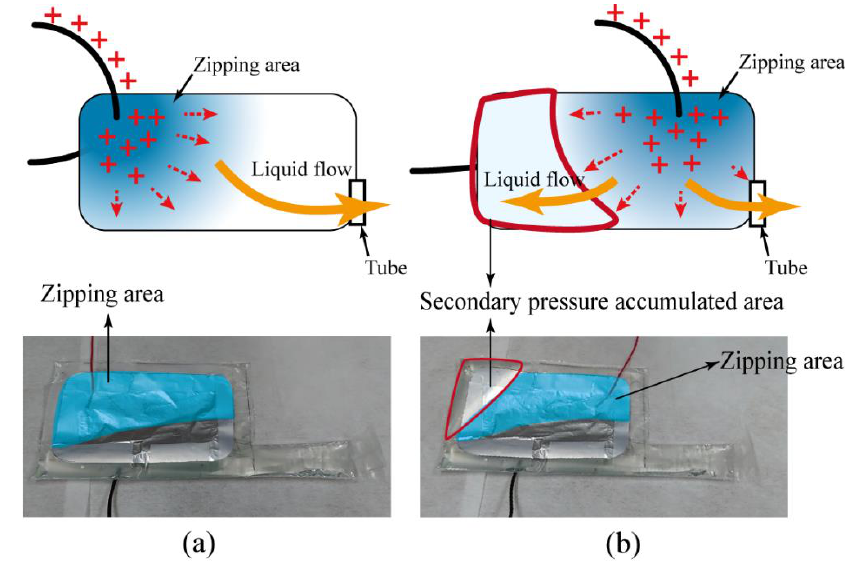
Figure 12. The effect of the locations of the copper wires. ( a ) If the copper wires were placed away from the tube, the actuation started at the bottom and pumped the liquid into the tube. ( b ) If the copper wires were placed near the tube, only a portion of liquid was pumped into the tube, and the rest was squeezed away from the tube. This formed a secondary pressure-accumulated area and significantly degraded the uncoil motion of the tube.